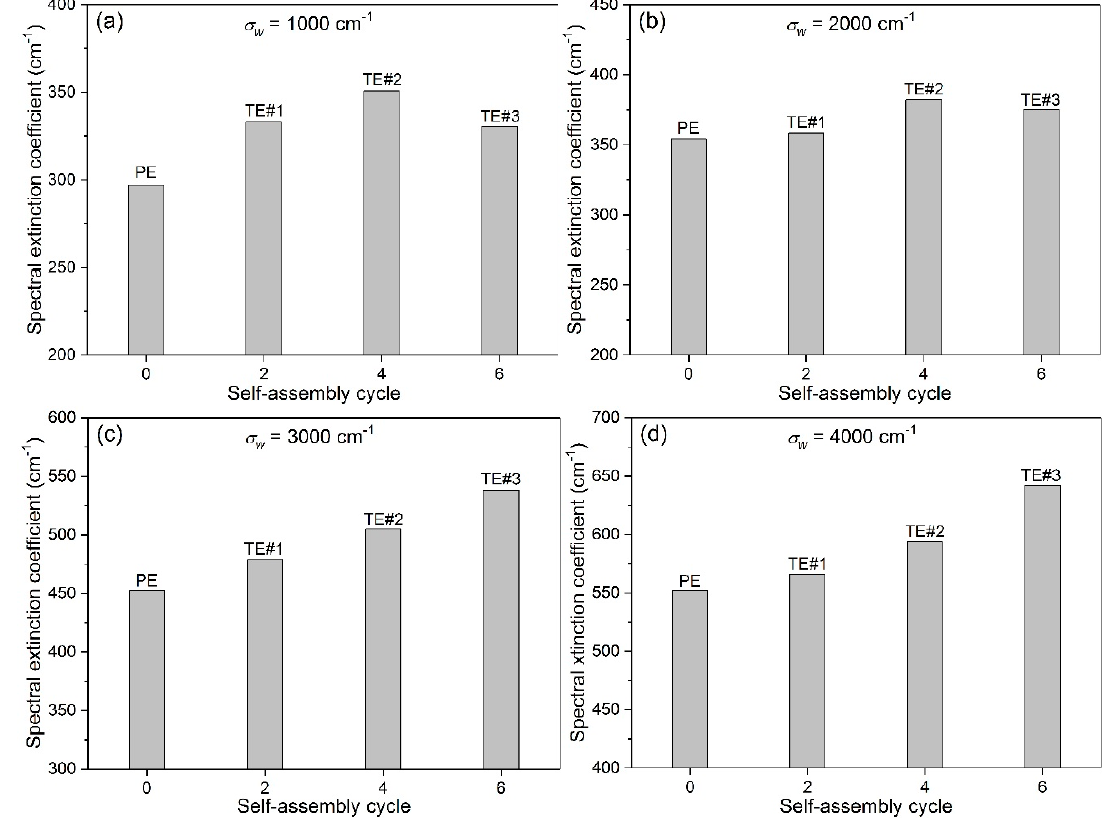
Figure 8. β λ for various self-assembly cycles wavenumbers of ( a ) 1000 cm − 1 ; ( b ) 2000 cm − 1 ; ( c ) 3000 cm − 1 , and ( d ) 4000 cm − 1